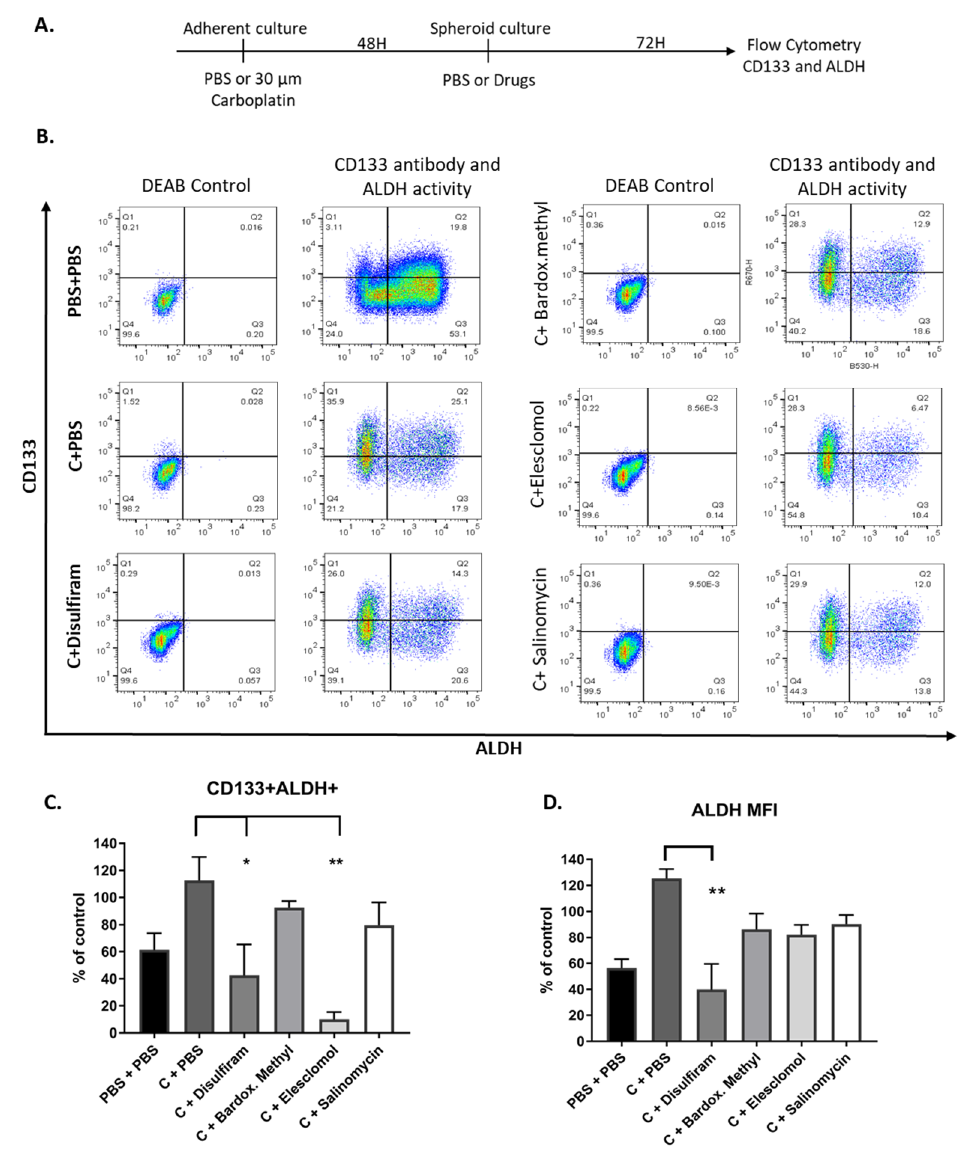
Figure 6. Drugs e ff ect on CD133 + ALDH high populations after carboplatin treatment. ( A ) Schematic of the assay of OV90 cells treated with 30 µ M carboplatin under adherent conditions for 48 h, and then switched to TIC-enriching spheroid growth conditions and treated with the candidate drugs at LD 50 concentrations for a further 72 h. ( B ) Representative images of CD133 + ALDH high populations in each treatment group. ( C ) CD133 + ALDH high double positive population expressed as percentage of control (Carboplatin + PBS). ( D ) ALDH geometric mean intensity, expressed as percentage of control (Carboplatin + PBS). Graphs represent mean and SEM Graphs represent mean and SEM of each treatment, distinguished by di ff erent degrees of grayscale shading compared to control * p < 0.05 ** p < 0.01.